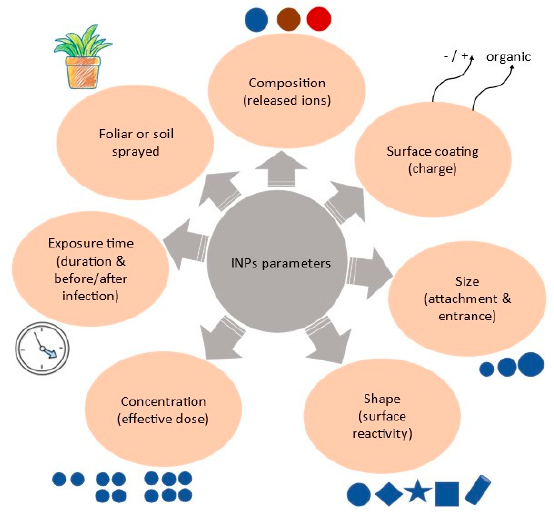
Figure 1. Schematic presentation of the INPs’ parameters that influence their performance as anti- phytopathogenic agents.